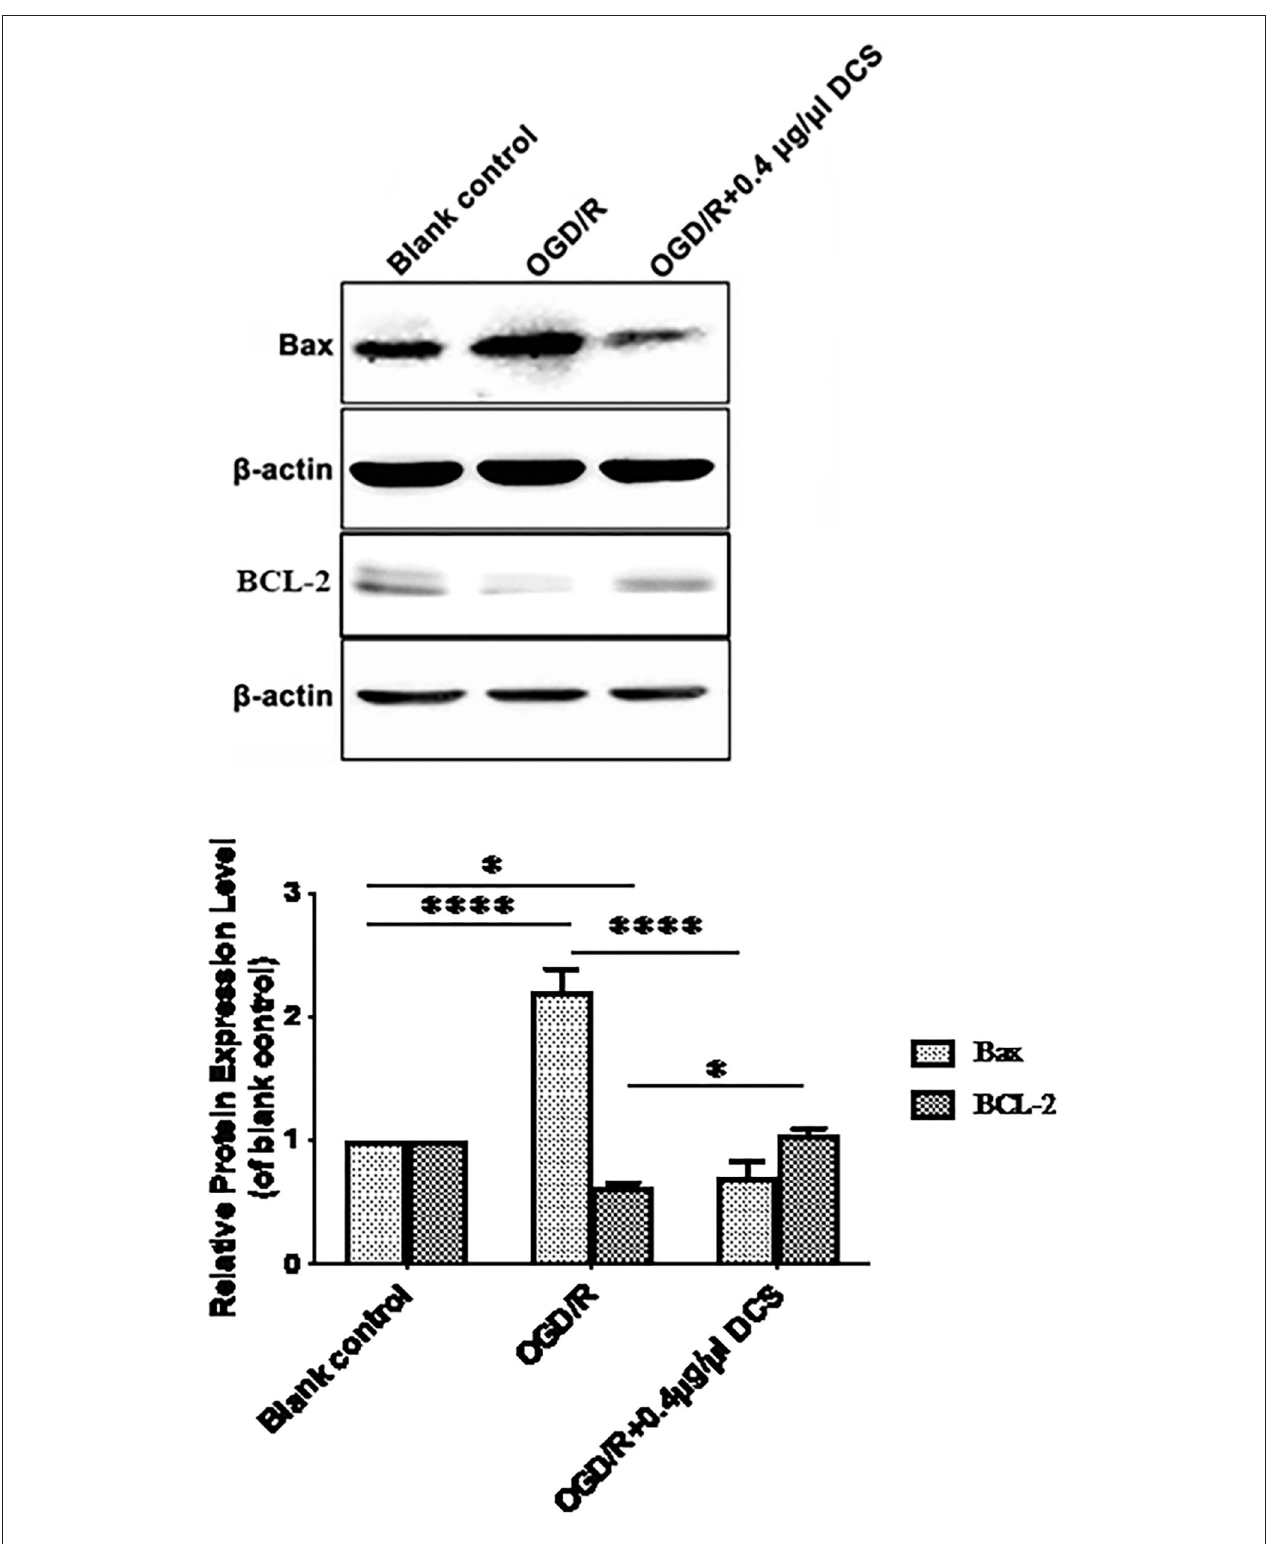
FIGURE 5 | Effects of DCS on the expressions of Bax and Bcl-2 proteins in cultured primary neurons exposed to OGD/R. Expressions of Bax and Bcl-2 proteins were determined by Western blot. β -Actin was used as an internal control. Blank control: cells not exposed to OGD/R; OGD/R: cells exposed to OGD/R; OGD/R + 0.4 µ g/ µ l DCS: cells exposed to OGD/R and 0.4 µ g/ µ l DCS for 4h. Data shown as mean ± SEM, n = 3. * p < 0.05, **** p < 0.0001.